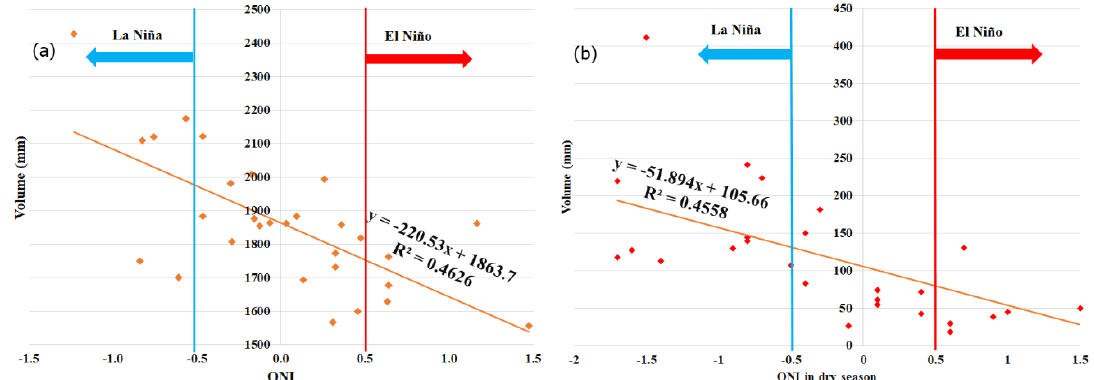
Figure 9. Relation between rainfall and ONI: ( a ) annual rainfall and annual average ONI and ( b ) rainfall in the four dry season months and average ONI in the dry season.